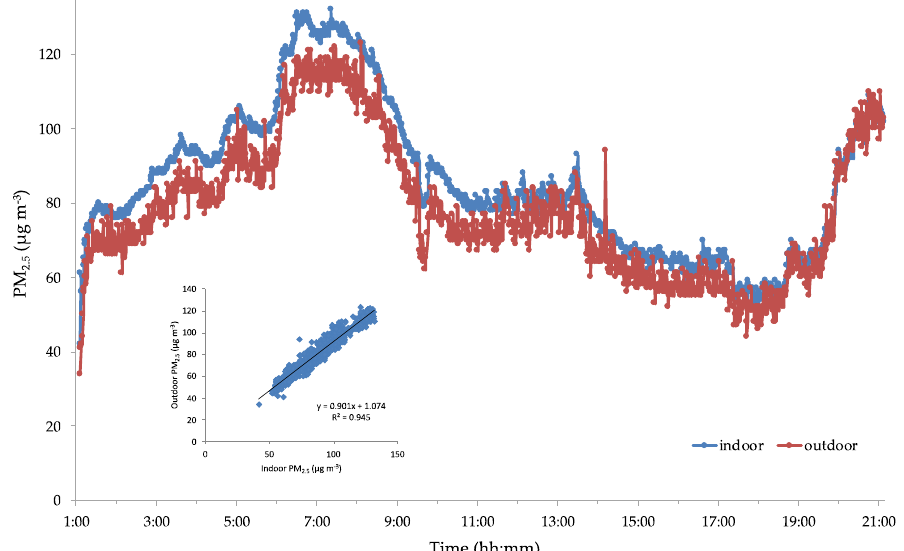
Figure 1. Field-comparison between two DustTrak instruments used for comparing indoor and outdoor measurements. The inner plot represents the correlation equation between the two datasets.